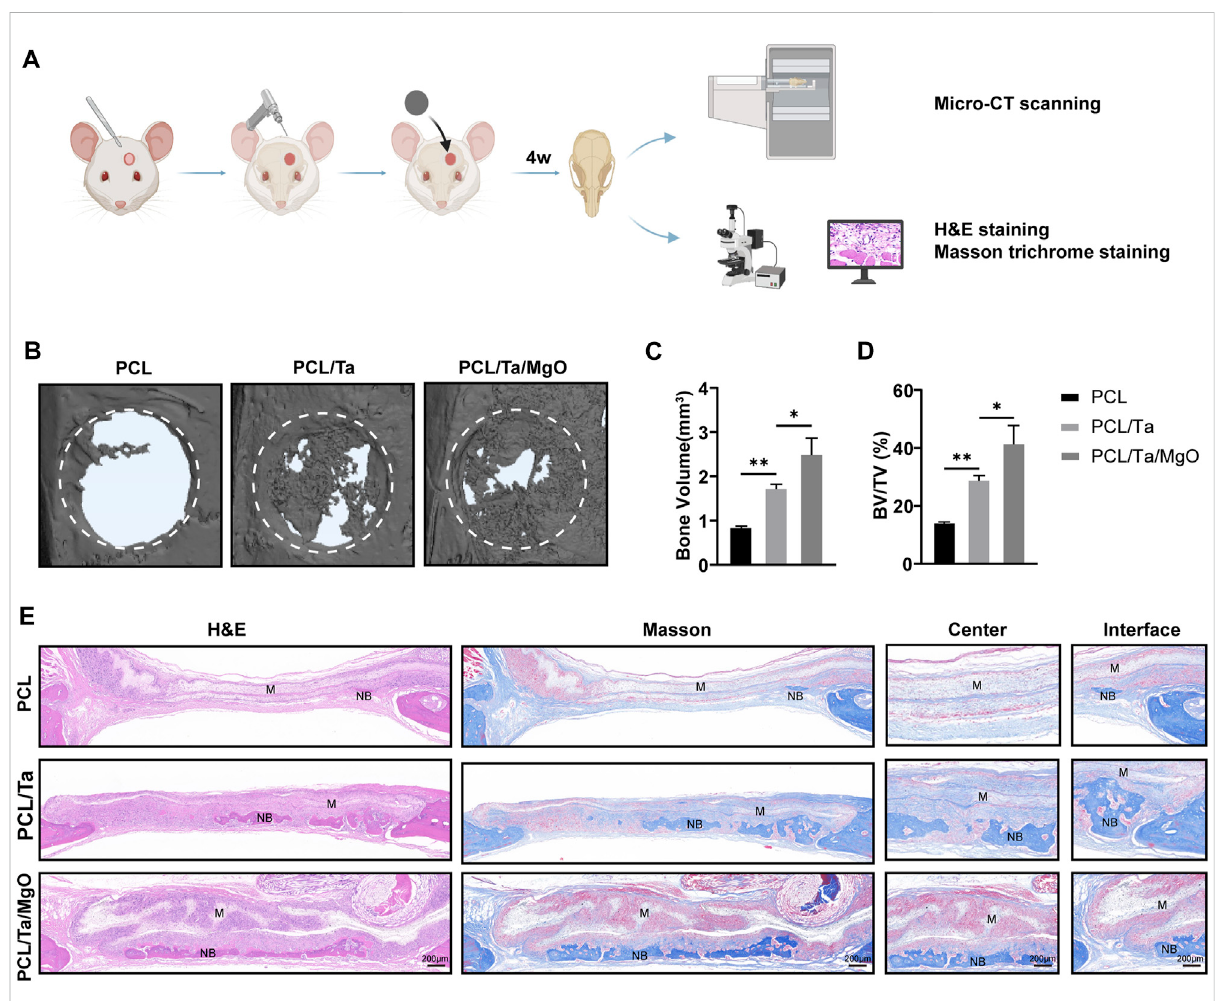
FIGURE 7 Evaluation ofthe invivo boneformation inratskulldefectsusingdifferentmembranes. (A) Schematicdraft oftheprocedure. (B) Representative scanningimagesbymicro-CTshowingthereconstructeddefectareasand (C) newlyformedbonevolume(BV)and (D) BV/TVquanti fi cationshowed bestrepairingeffectsoriginatingfromPCL/Ta/MgOmembranes( n =3). (E) RepresentativehistologicalimagesofdifferentmembraneswithH&Eand Masson staining after 4 weeks. (M: material; NB: new bone) (* p < 0.05, ** p < 0.01, *** p < 0.001, and **** p <